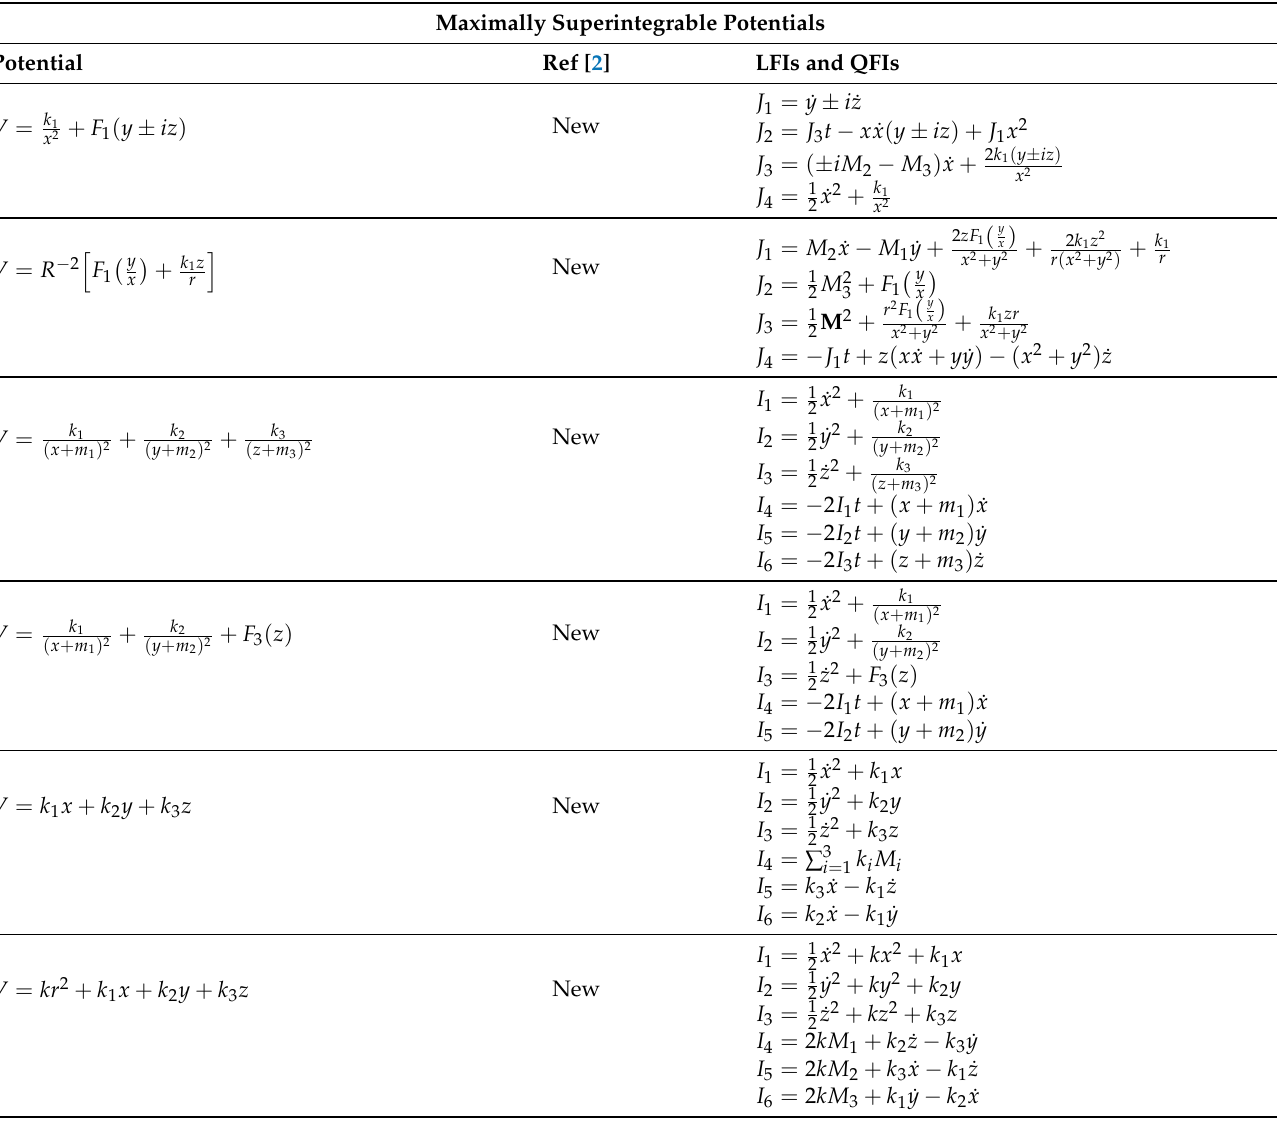
Table 9. Maximally superintegrable potentials V ( x , y , z ) in E 3 that admit QFIs of the form I ( 2,0 ) .